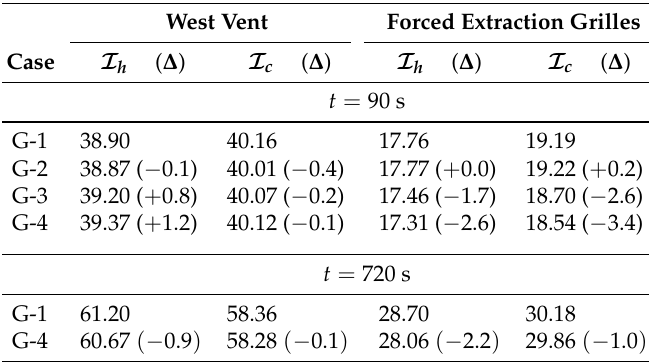
) and mass of CO 2 ( ) extracted by the natural and forced Table 3. Fractions (in %) of heat ( I h I c ventilation systems (Equation (6)). In parentheses, variation (in %) with respect to Case G-1. Values obtained with FDS and the simplified fire model after the first 90 s (cases G-1 to G-4) and 720 s (cases G-1 and G-4) of the fire. West Vent Forced Extraction Grilles